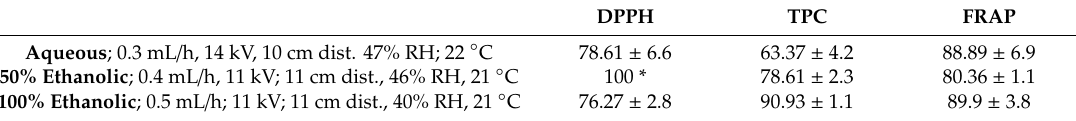
Table 2. Percentage loss of antioxidant activity per gram of dried extract subject to electrospinning. * No DPPH radical reduction was detected using the available instrumentation. Values displayed correspond to the average of three samples assayed in triplicate, ± standard deviation.